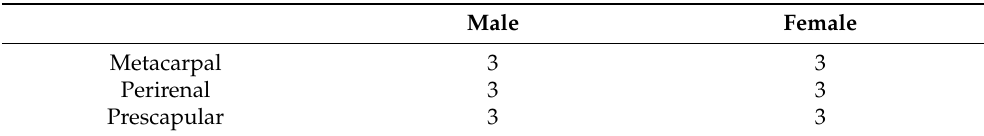
Table 1. Summary of adipose tissue samples.